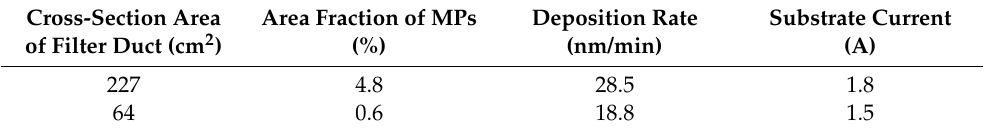
Table 2. Area fraction of MP density, deposition rate, and substrate current with different cross-section areas.